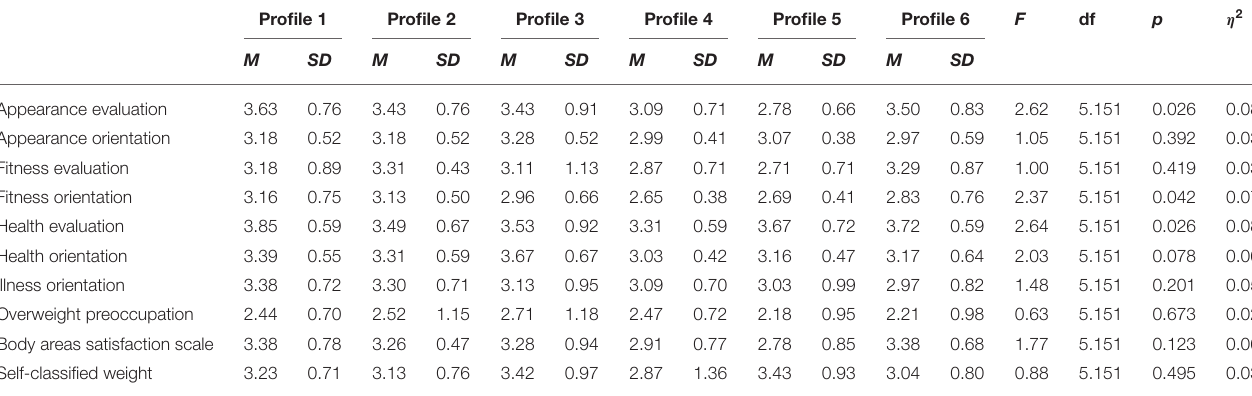
TABLE 6 | Mean values of body image indicators with values of one-way ANOVA.